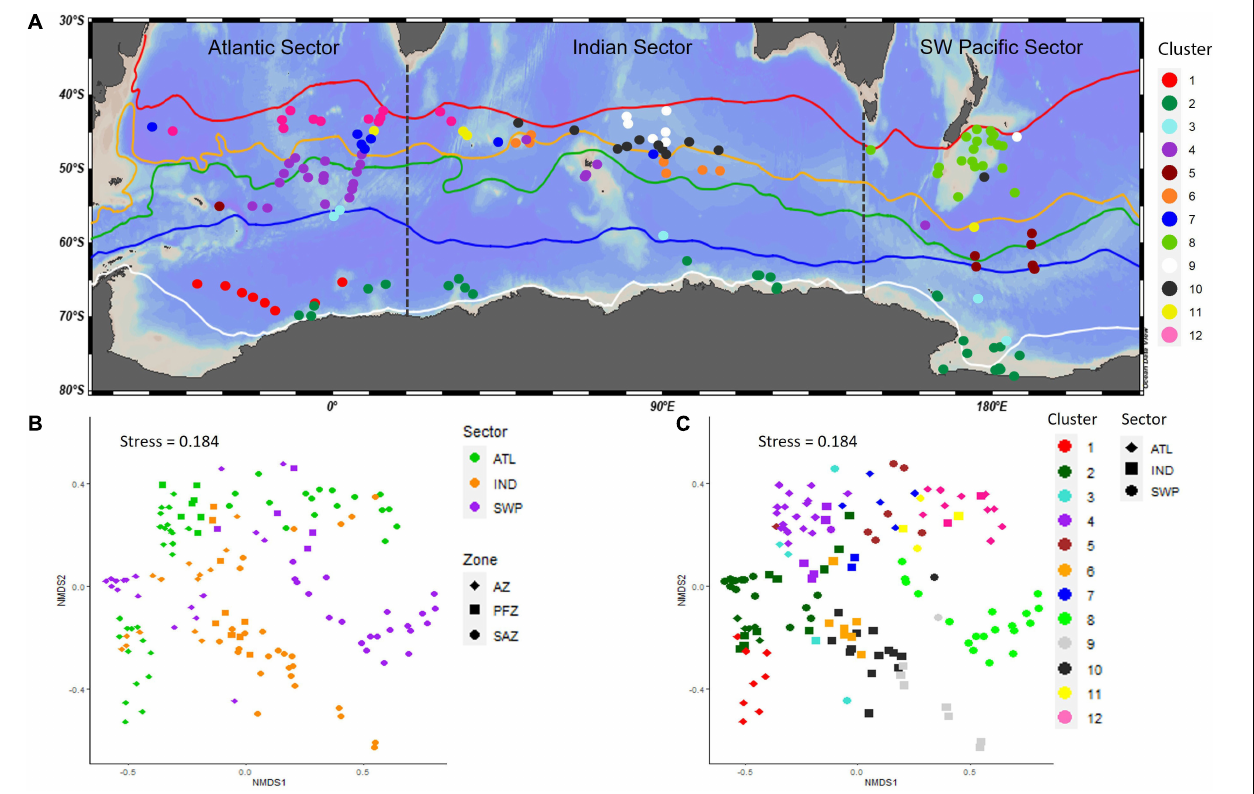
FIGURE 2 | Sites of the SO-RAD with the Southern Ocean from the Subtropical Front to the Antarctic Zone. (A) Map of distribution of clusters determined by MRT analysis of sites within the Southern Ocean; STF, Subtropical Front; SAF, Subantarctic Front; APF, Antarctic Polar Front (Orsi et al., 1995); STZ, Subtropical Zone; SAZ, Subantarctic Zone; PFZ, Polar Frontal Zone; POOZ, Permanently Open Ocean Zone; SIZ, Seasonal Sea-Ice Zone; WSI, Winter Sea-Ice Margin; SSI, Summer Sea-Ice Margin. (B) nMDS of Hellinger transformed relative abundance of Southern Ocean sites. Shape depicts the zone: Antarctic Zone (AZ), Polar Frontal Zone (PFZ), and Subantarctic Zone (SAZ). Color depicts sector: ATL, Atlantic Sector; IND, Indian Sector; SWP, Southwest Pacific. (C) nMDS as per (B) , color depicting MRT clusters and shape depicting Sector. Please see Supplementary Figure 1 for a color blind alternative.